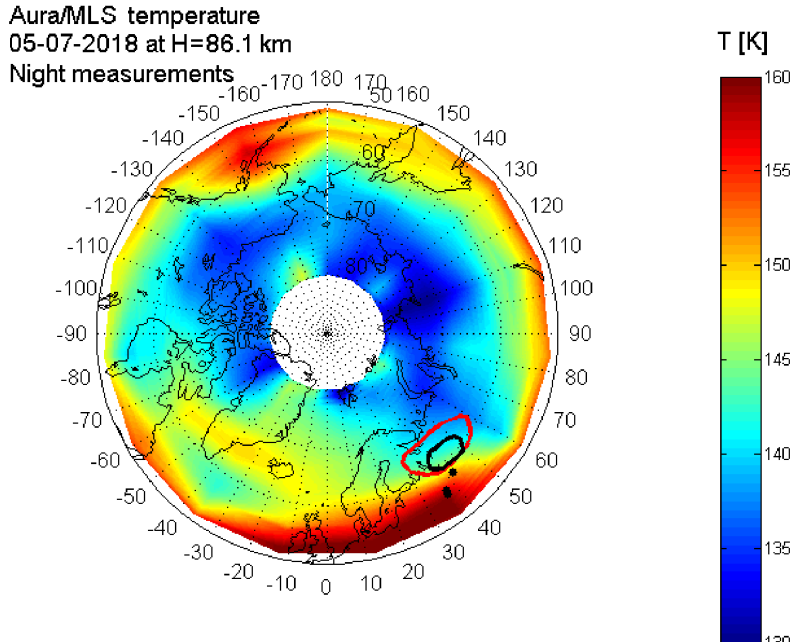
Figure 3. The temperature map at the mesopause (geometric height of 86.1km) as measured by the Aura/MLS spectrometer on 5 July 2018. Nighttime measurements around the globe have been selected to produce the map. Upon the temperature map, the outer borders of the NLC field (the actual NLC coverage) are overplotted: the red line is as seen from the SONC balloon, and the black line is as seen from the ground at the launch. The black dots mark the position of the balloon at 7.8km at the ground and ground-based